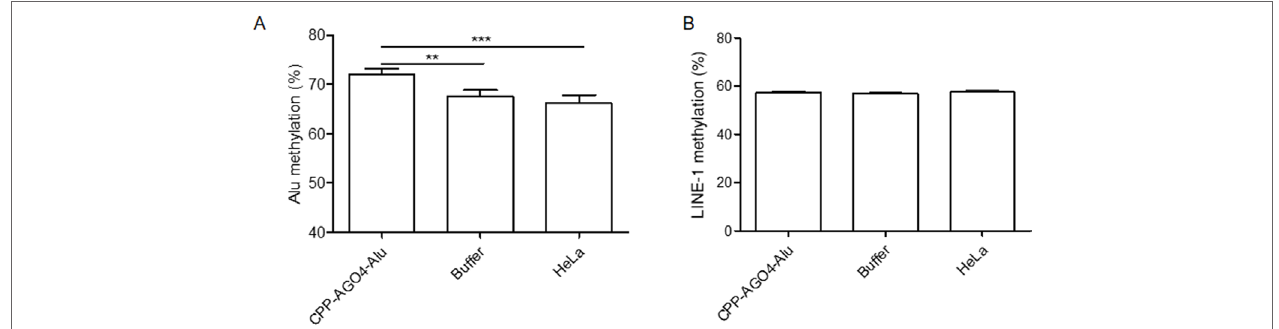
FIGURE 7 | AGO4 protein specifically induced DNA methylation of target loci. By using CPP-AGO4 conjugated with Alu sgRNA (CPP-AGO4-Alu) transfected to HeLa cells, we found that (A) Alu methylation level was significantly increased in CPP-AGO4-Alu transfected cells, while Alu methylation was not promoted in control counterpart groups. (B) While LINE-1 methylation level was not changed, this means the complex has no off targets to LINE-1. The representative dataset was obtained from five independent experiments. Statistical analyses were performed using a paired-sample T -test where p < 0.05 and p < 0.01 are represented as * and **, respectively, where buffer means non-inducible CPP-AGO4